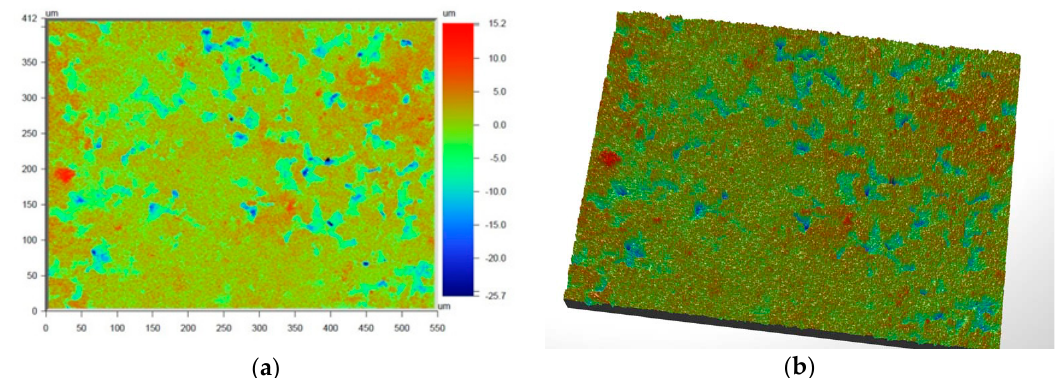
Figure 14. 2D ( a ) and 3D ( b ) profilographs of PW3 sample at a magnification of ×2.9.